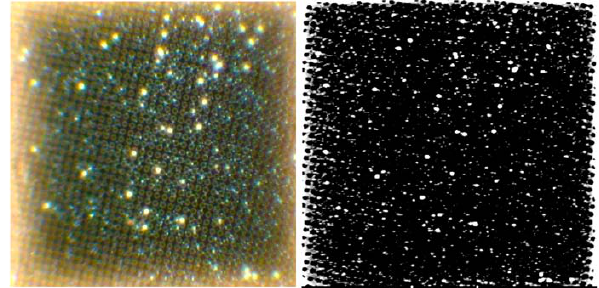
Fig. 7. Comparison of particle identification between the Fast TRAC and the scanning electron microscope. Left is an optical micro-videograph of the substrate with many particles of various sizes taken using the Fast TRAC setup. Right is the same region imaged in a scanning electron